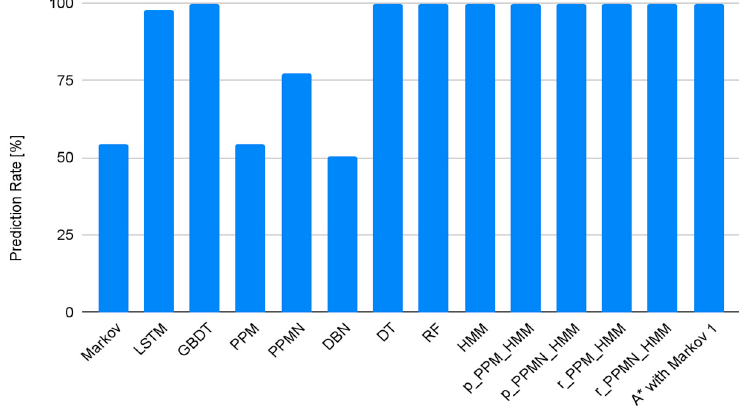
Figure 10. Prediction rate on the students’ dataset.